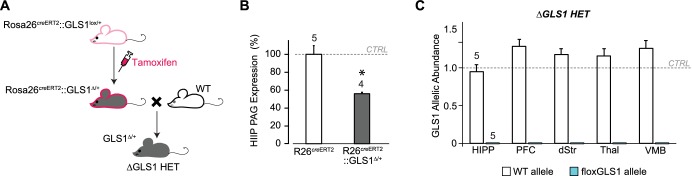
Breeding ΔGLS1 HET mice (with a global GLS1 reduction) from floxGLS1 mice.(A) Inducible Rosa26creERT2: : GLS1lox/+ mice (pink outline) were used to produce a global heterozygous GLS1 inactivation in adulthood by tamoxifen-induced recombination of the floxGLS1 allele. These Rosa26creERT2: : GLS1Δ/+ mice (gray with pink outline) were bred with wild-type (WT) C57BL6 mice (white) to generate ΔGLS1 HET mice (gray). (B) Expression of PAG in the hippocampus (HIPP) of Rosa26creERT2: : GLS1Δ/+ mice after tamoxifen revealed that the protein was reduced to 55.5% of control levels measured in Rosa26creERT2 mice. These mice were bred with WT mice to generate ΔGLS1 HET mice. * indicates significant difference from CTRL (Rosa26creERT2) (ANOVA, F(1,7) = 20.15, p=0.003, ES partial η2 = 0.742). (C) GLS1 allelic abundance for WT and floxGLS1 alleles in ΔGLS1 HET mice showed one WT allele and the absence of the floxGLS1 allele (blue bars) in the hippocampus (HIPP), prefrontal cortex (PFC), dorsal striatum (dStr), thalamus (Thal) and ventral midbrain (VMB), further validating the global heterozygous GLS1 deletion. Allelic abundance data were normalized to CTRL values in GLS1 lox/+ (gray line). See Figure 6—figure supplement 2—source data 2.xlsx for source data and statistical analysis.DOI:
http://dx.doi.org/10.7554/eLife.27566.026
10.7554/eLife.27566.027Figure 6—figure supplement 2—source data 2.PAG protein determinations in Rosa26ERT2creGLS1 mice.